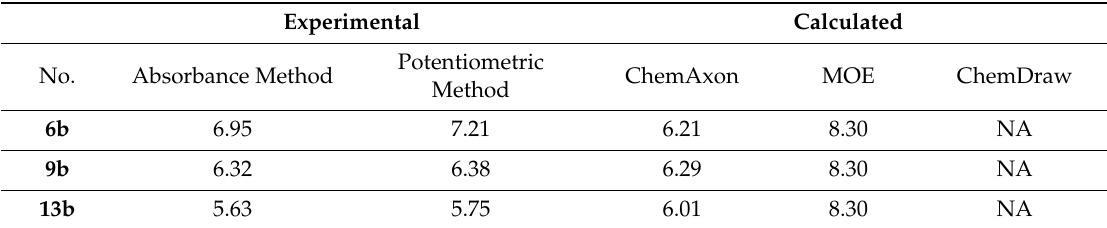
Table 2. Experimental and calculated p Ka values of compounds 6b , 9b , and 13b .